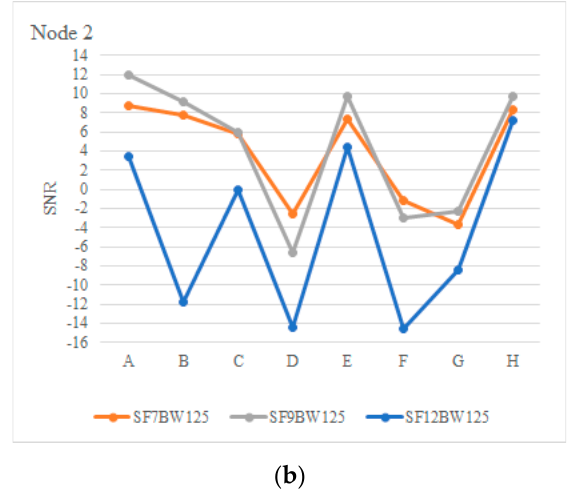
Figure 14. Radio SNR (dBm): ( a ) Node, ( b ) Node 2.